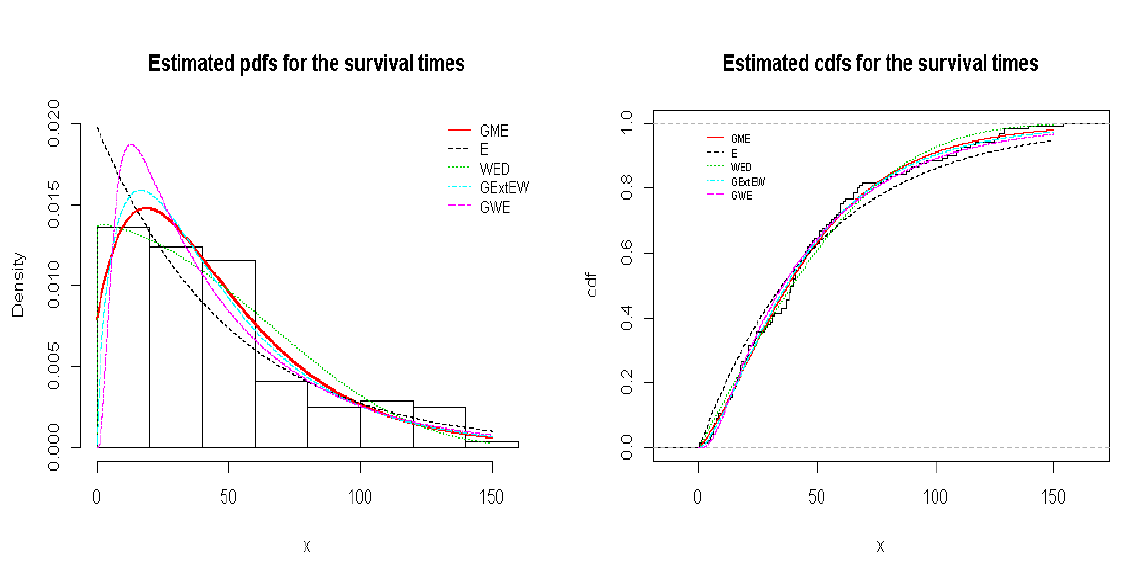
Figure 9. Fitted pdfs and the relative histogram, empirical and fitted